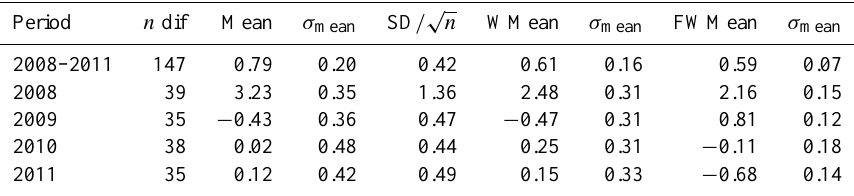
Table 5. Mean differences between results from the NOAA flask samples and coincident in situ hourly means (NOAA minus in situ) and standard deviations of the means (in nmolmol − 1 ). n dif denotes the number of differences available. √ Period n dif Mean σ mean SD /